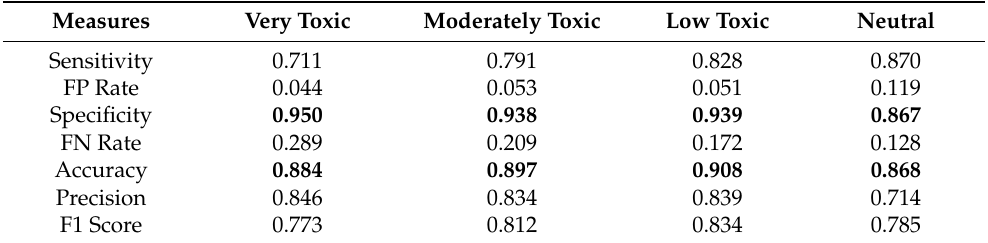
Table 7. Effectivity of SVM2 model for recognition of four degrees of toxicity in online discussions.